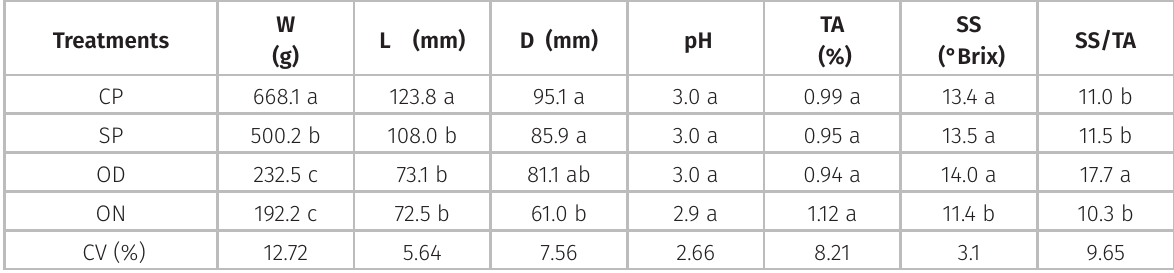
Table II. Fruit weight (W), length (L), diameter (D), pH, titratable acidity (TA), soluble solids (SS), and SS/TA ratio. Pollinations performed on 02/14/19. Treatments: cross-pollination (CP), self-pollination (SP), diurnal open pollination (OD), and nocturnal open pollination (ON).